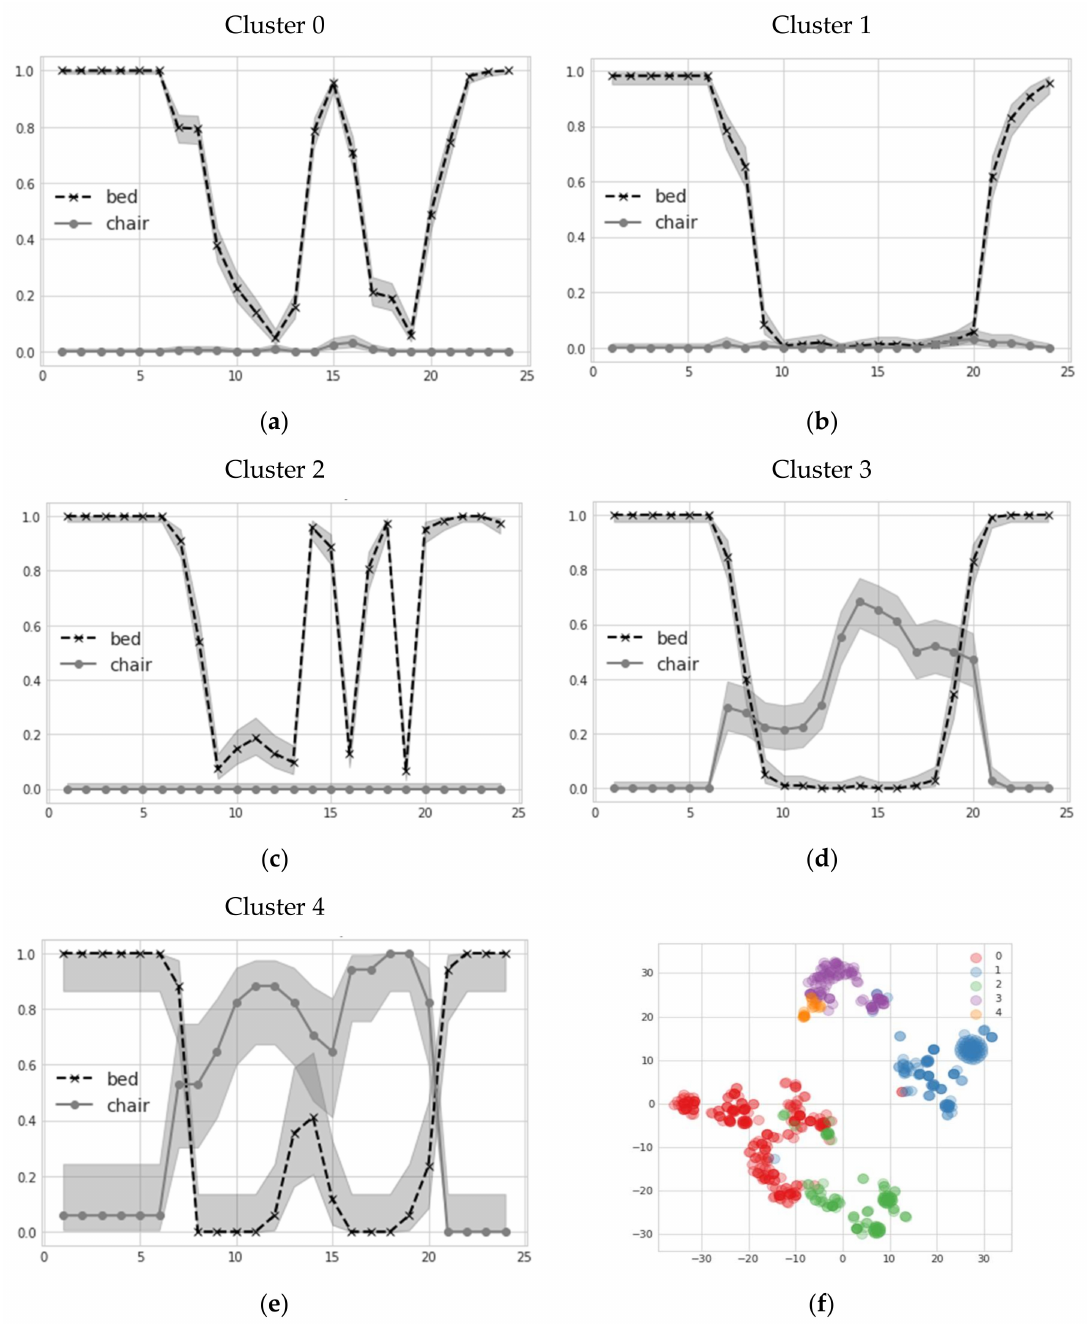
Figure 7. ( a – e ) Examples of MHC clusters extracted by GRU-based embedding; ( f ) 2D visualization (obtained by applying the t-SNE manifold learning algorithm) of embedded space induced by GRU. Different colors refer to the clusters found in the sub-figures ( a – e